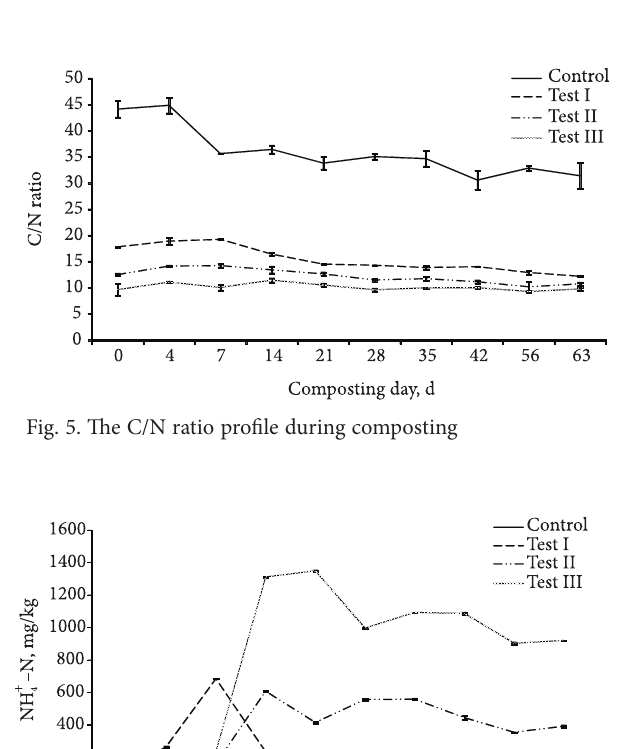
Fig. 4. The T-N profile during composting